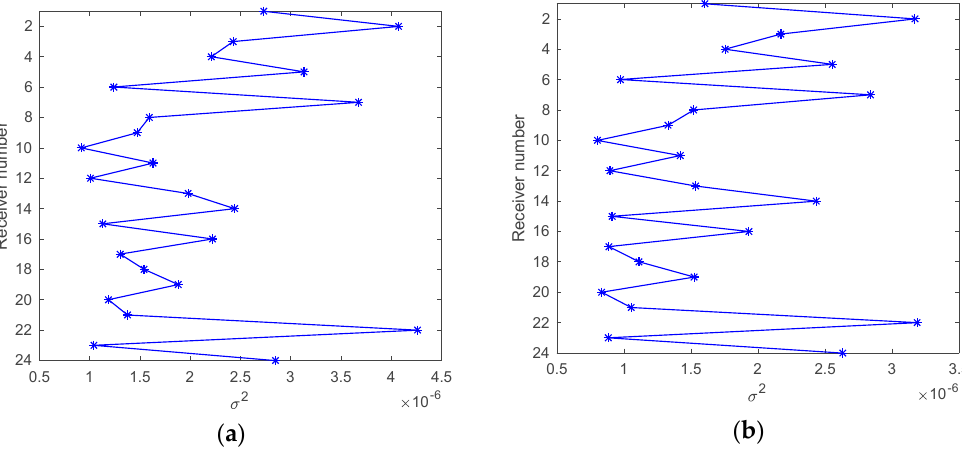
Appl. Sci. 2021 , 11 , x FOR PEER REVIEW Figure 5. The received noise power of each array element. ( a ) 50 km UWA communication; ( b ) 80 km UWA communication.